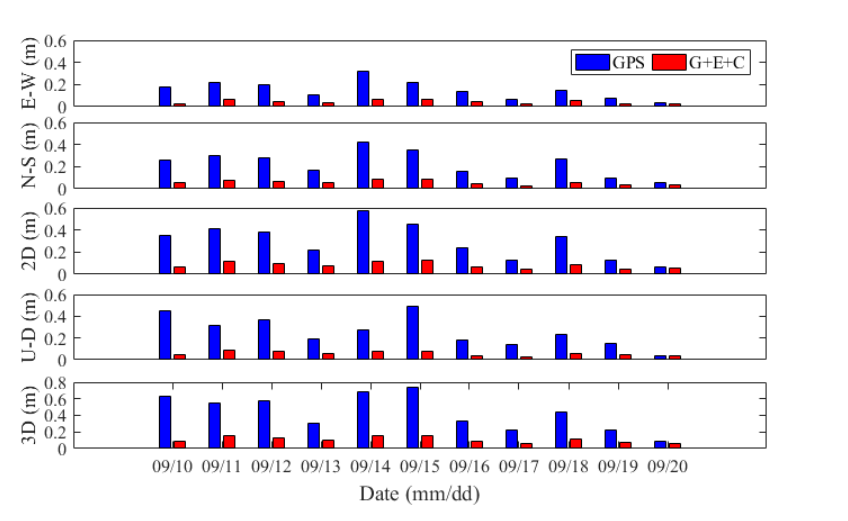
Figure 12. RMS values of DF RT–PPP in the east, north, horizontal (2D), up, and 3D directions for GPS and multi–GNSS from 10 September to 20 September 2019.